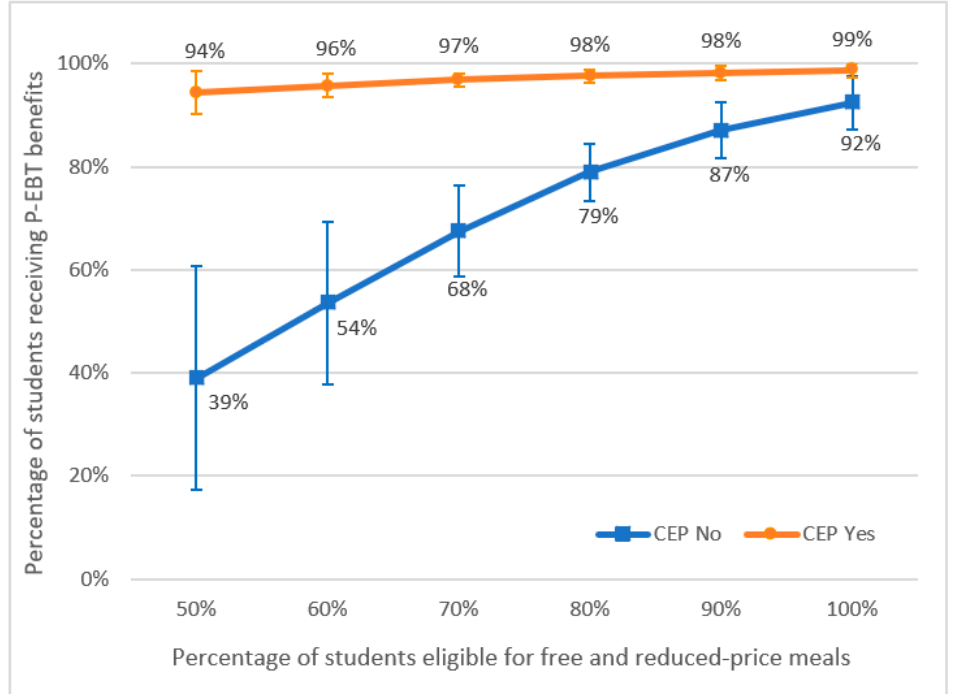
Figure 1. Pandemic Electronic Benefits Transfer (P-EBT) receipt by Community Eligibility Provision (CEP) participation status of the